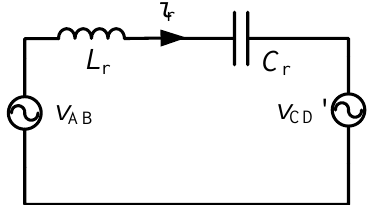
Figure 3. Simplified circuit model of the converter.